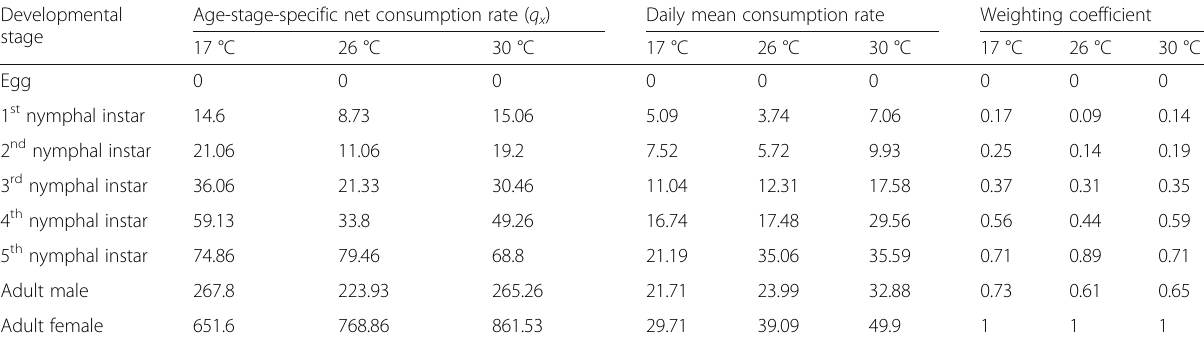
Table 2 Age-specific net consumption rate ( q x ), daily mean consumption rate, and weighting coefficient of Anthocoris minki pistaciae fed with Agonoscena pistaciae at three different temperatures under laboratory conditions Developmental